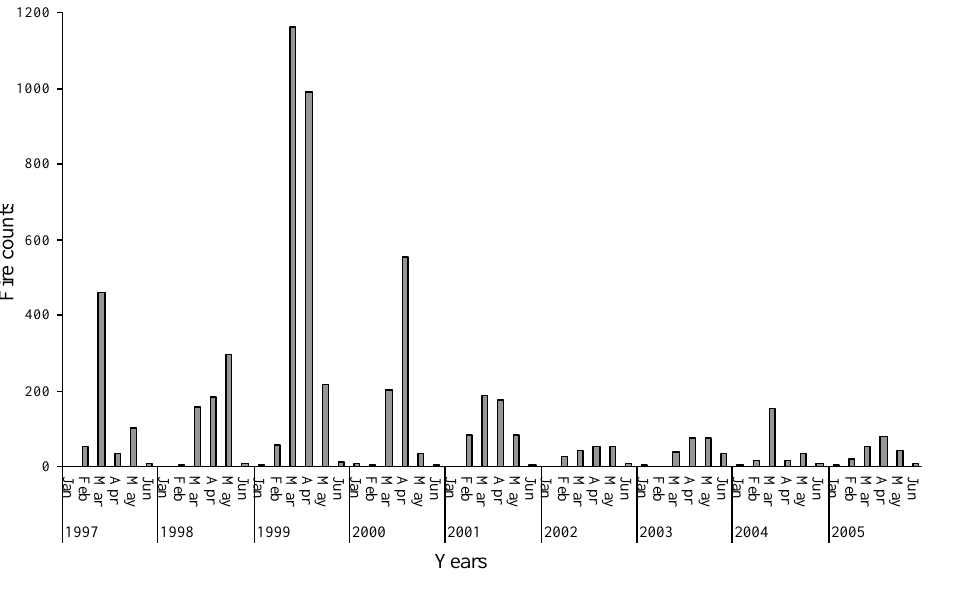
Figure 3. Fire occurrence data using A(A)TSR night-time data over Indian region for peak fire season from January to June